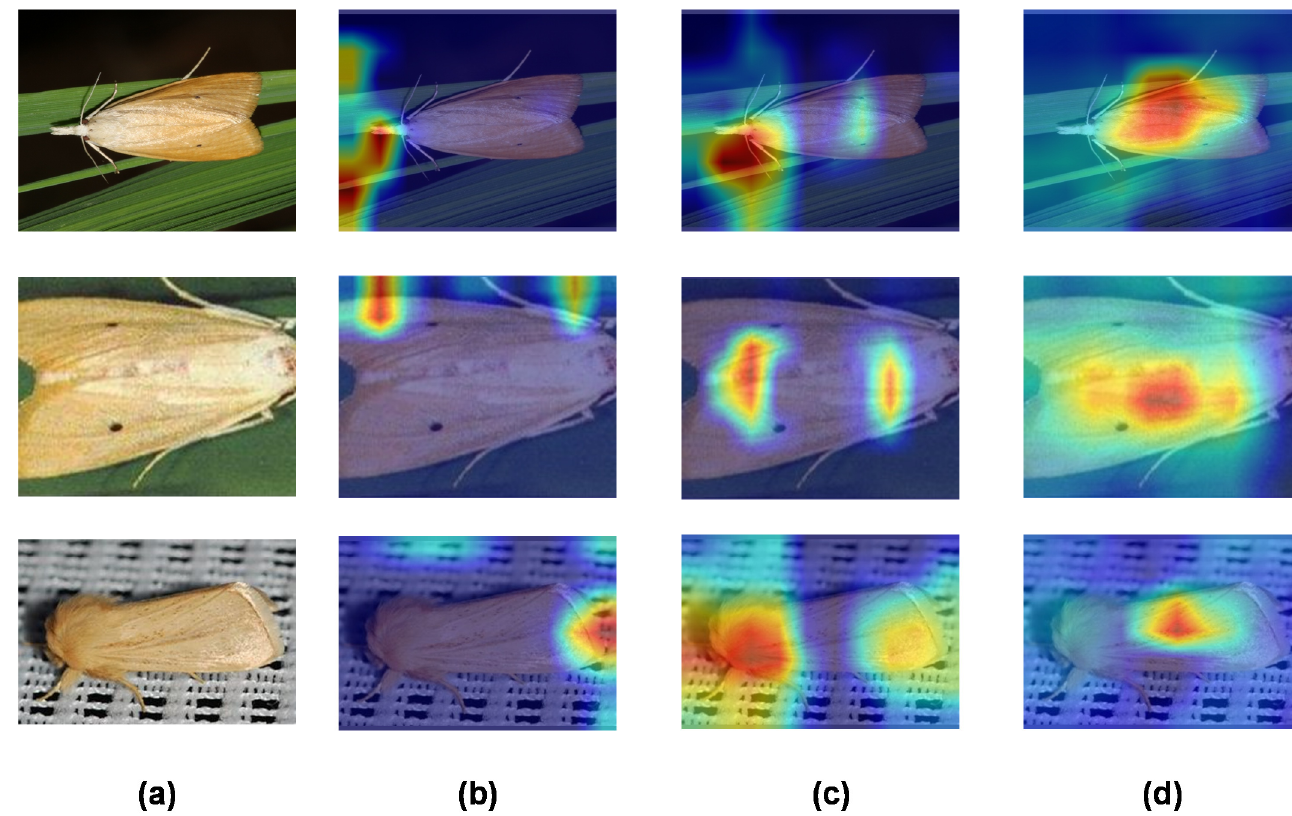
Figure 13. Visualization of the feature maps. ( a ) The original images; ( b ) the heatmaps of layer 10 in backbone; ( c ) the heatmaps of the BiFPN structure; ( d ) the heatmaps of the output layer.